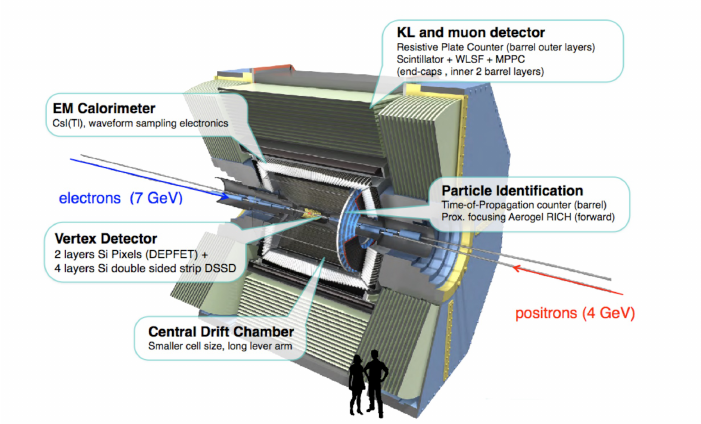
Figure 3. Overview of the Belle II detector. DEPFET, DEpleted P-channel Field Effect